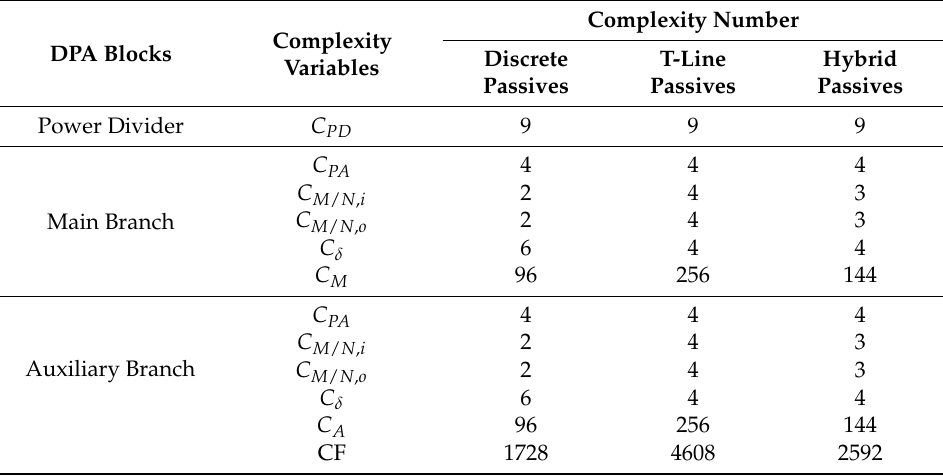
Table 1. Base figures for